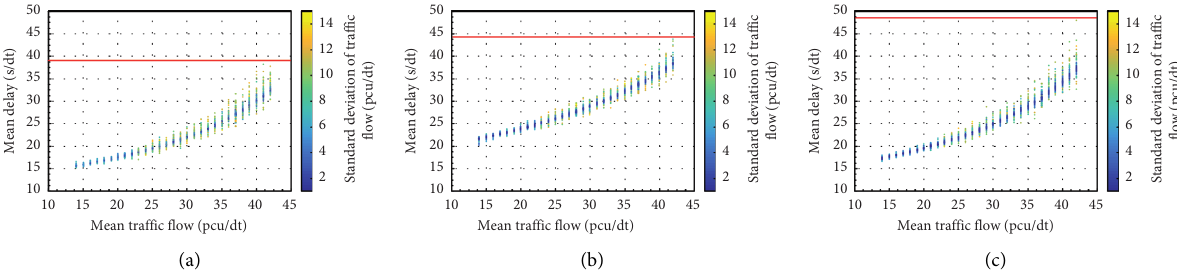
Figure 7: Average delay under different saturations with different intercycle flow standard deviations. (a) Dynamic control. (b) Plan selection control. (c) Pretimed